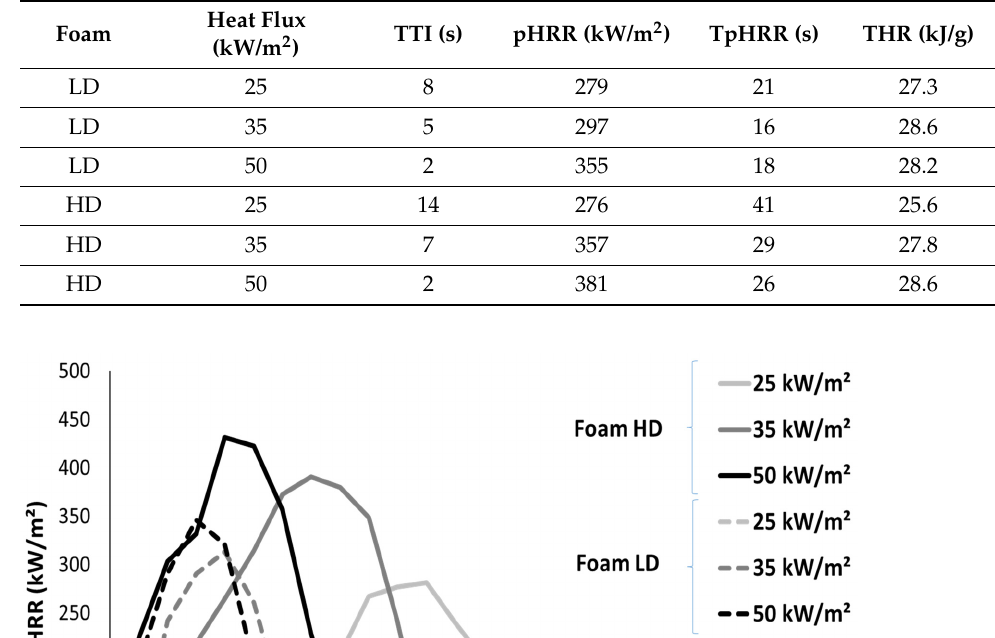
Table 3. Main data from cone calorimeter tests on 2 cm-thick foams.